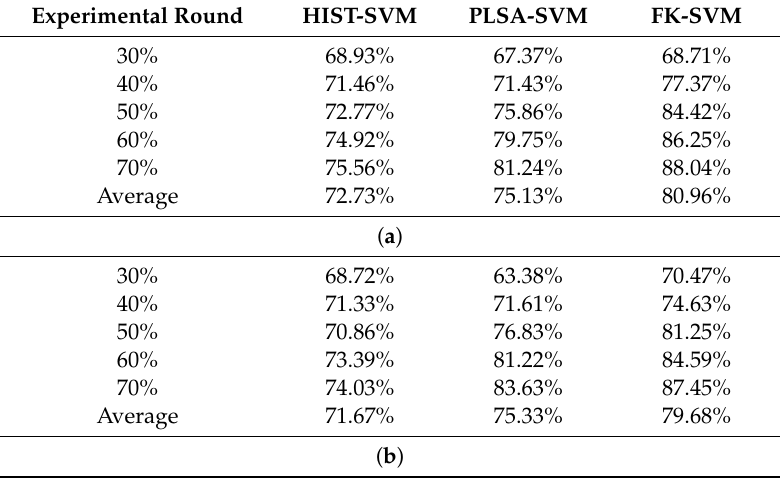
Table 2. Sample comparison of di ff erent training percentages of FK-SVM, HIST-SVM and PLSA-SVM. (a) Precision. (b) Recall